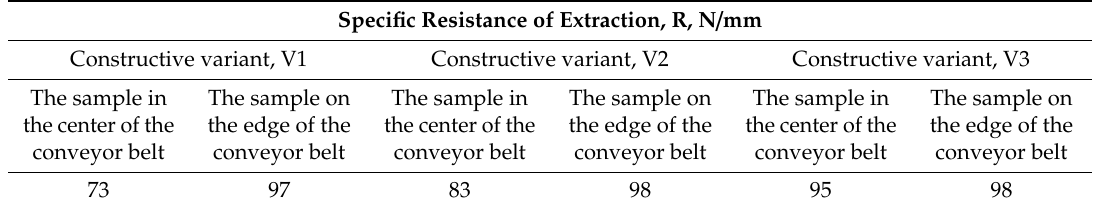
Table 6. The values of the specific resistance of extraction.